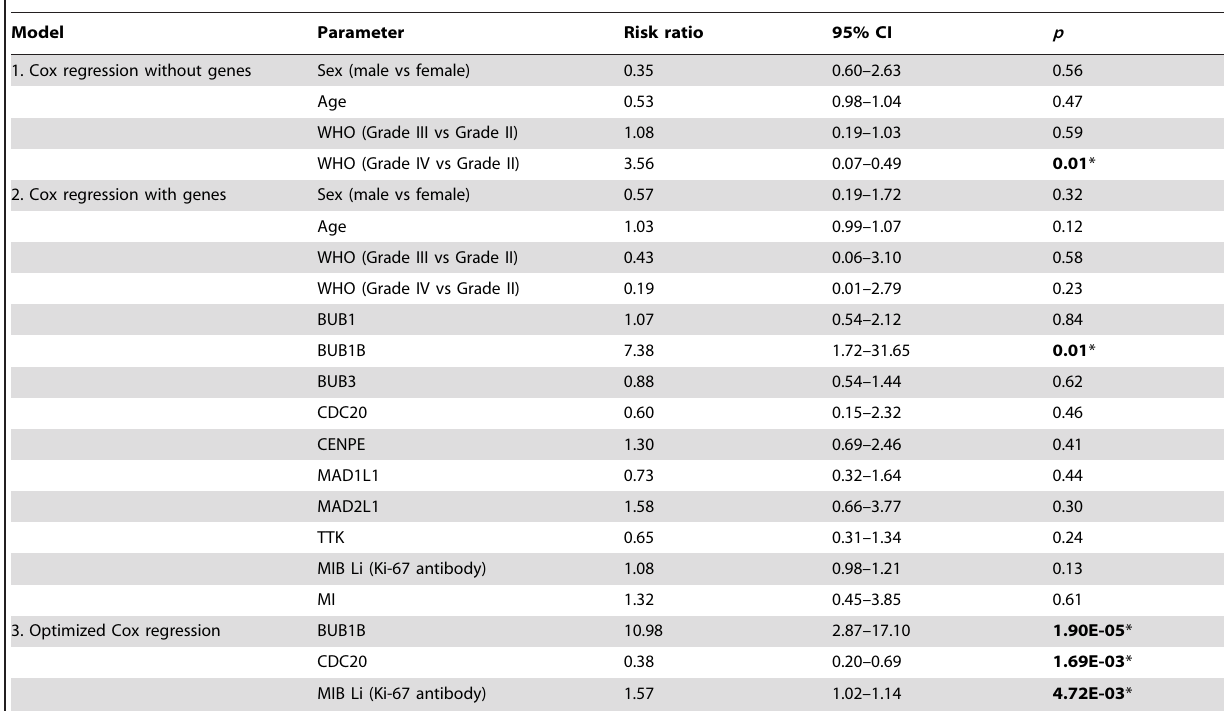
Table 4. Multivariate analysis on survival time.